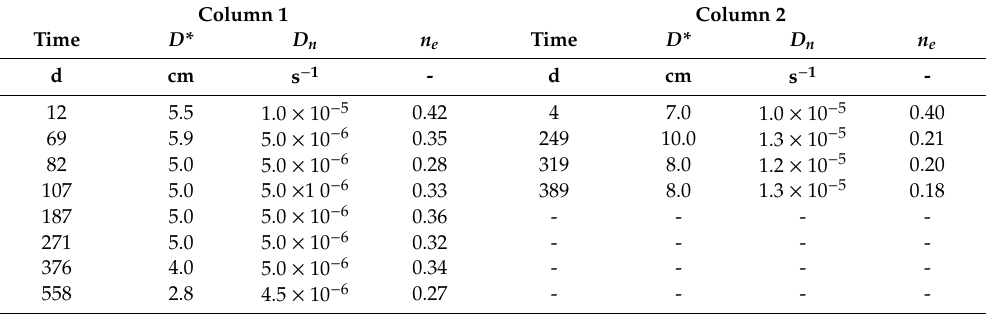
Table 2. Tracer test calibration in column experiments using the PHREEQC double porosity model. Column 1 Column 2